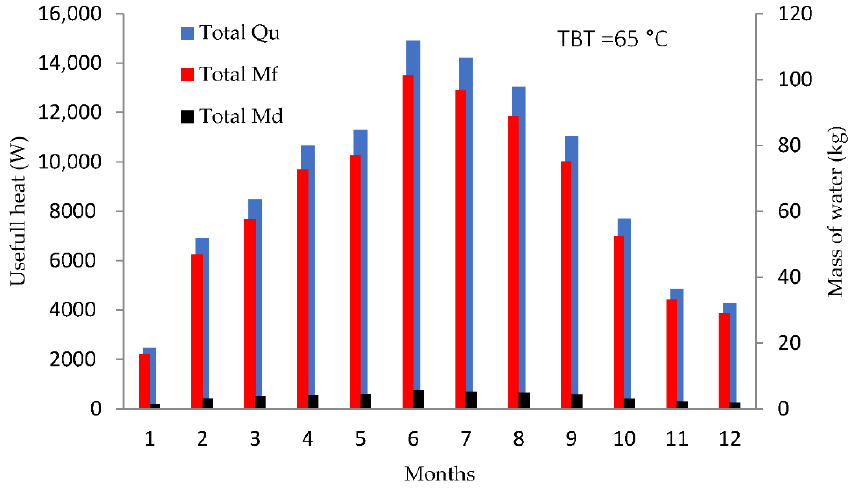
Figure 7. Average change of feed water, useful heat, and production. The mass flow rate ratio (MR) is defined as the ratio of inlet feed water mass flow rate to the inlet mass flow rate of dry air circulated in the HDH unit.